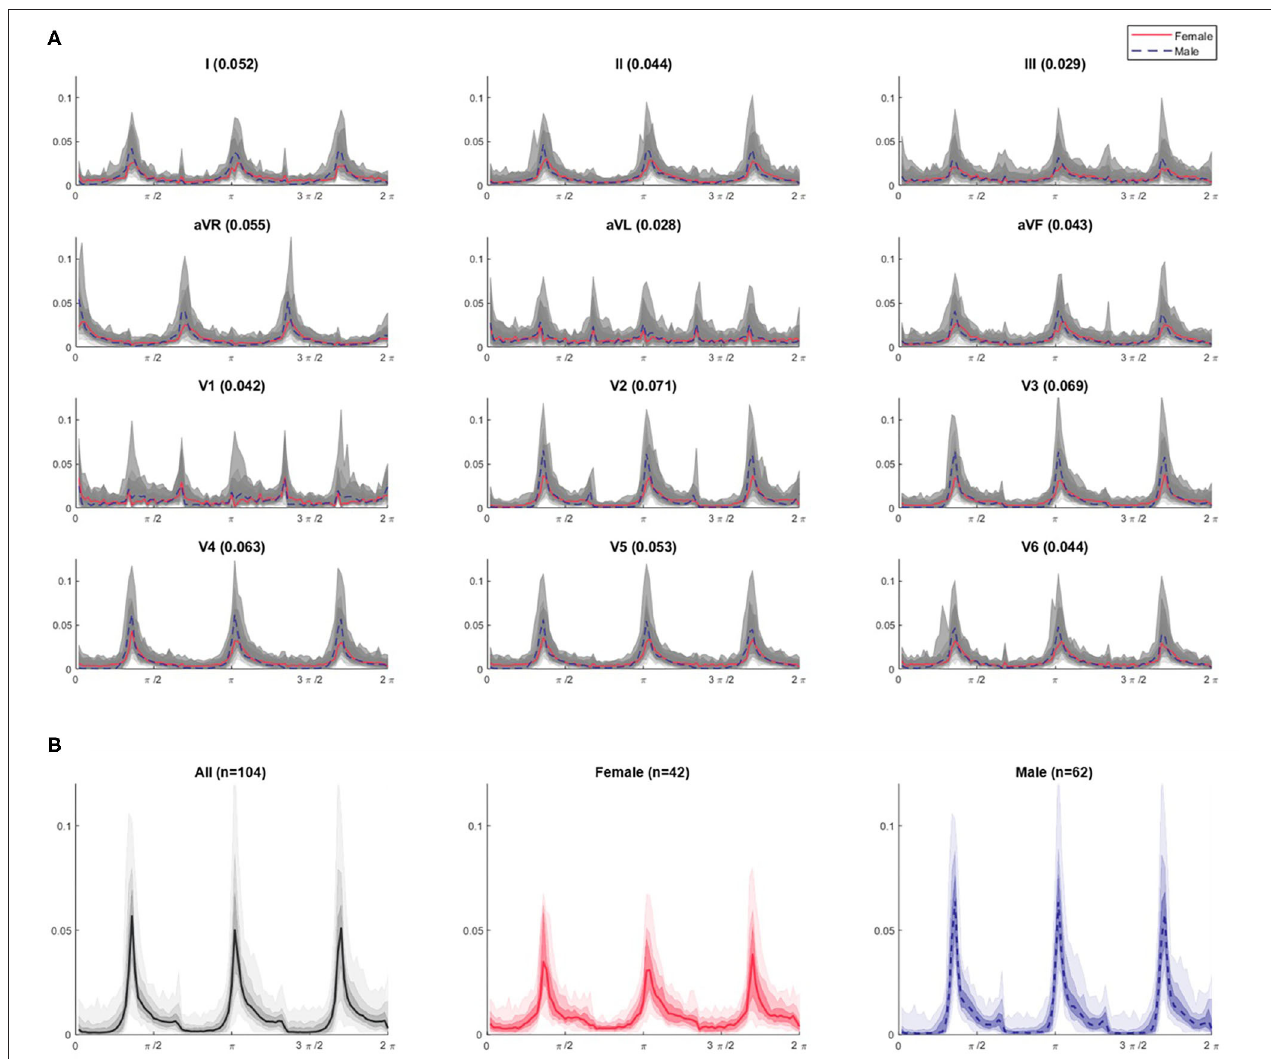
FIGURE 5 | θ density profiles from 3-point attractors by lead for Dataset 1 (A) with a focus on the lead V3 profiles (B) . (A) The appearance of the profile over all subjects is shown in gray and appears relatively homogeneous for a given lead. The shaded gray bands provide the centiles on data, with the darkest being 25th – 75th centile, extending to all the data with the lightest band. However, when the median profile is split between female (red solid line) and male (blue dotted line) subjects, differences between the sexes can be seen. A simple quantification of the difference can be provided by considering the Euclidean distance between the female and male median lines, and is given by the bracketed number in each plot title. These distance values are greatest for leads V2 through V4 (0.071, 0.069, 0.063, respectively), supporting our visual interpretation of the plots as being where the largest sex differences occur. Similar observations can be made on the r, θ and attractor outline r profiles for the other N-point attractors, especially regarding differences in the mid-precordial leads. (B) For lead V3, we can clearly observe different appearances if we separate the profiles by sex. Female attractors appear to have lower θ density peaks and a more general spread of density across the attractor, compared with the higher θ density peaks of males contrasting with areas of very low